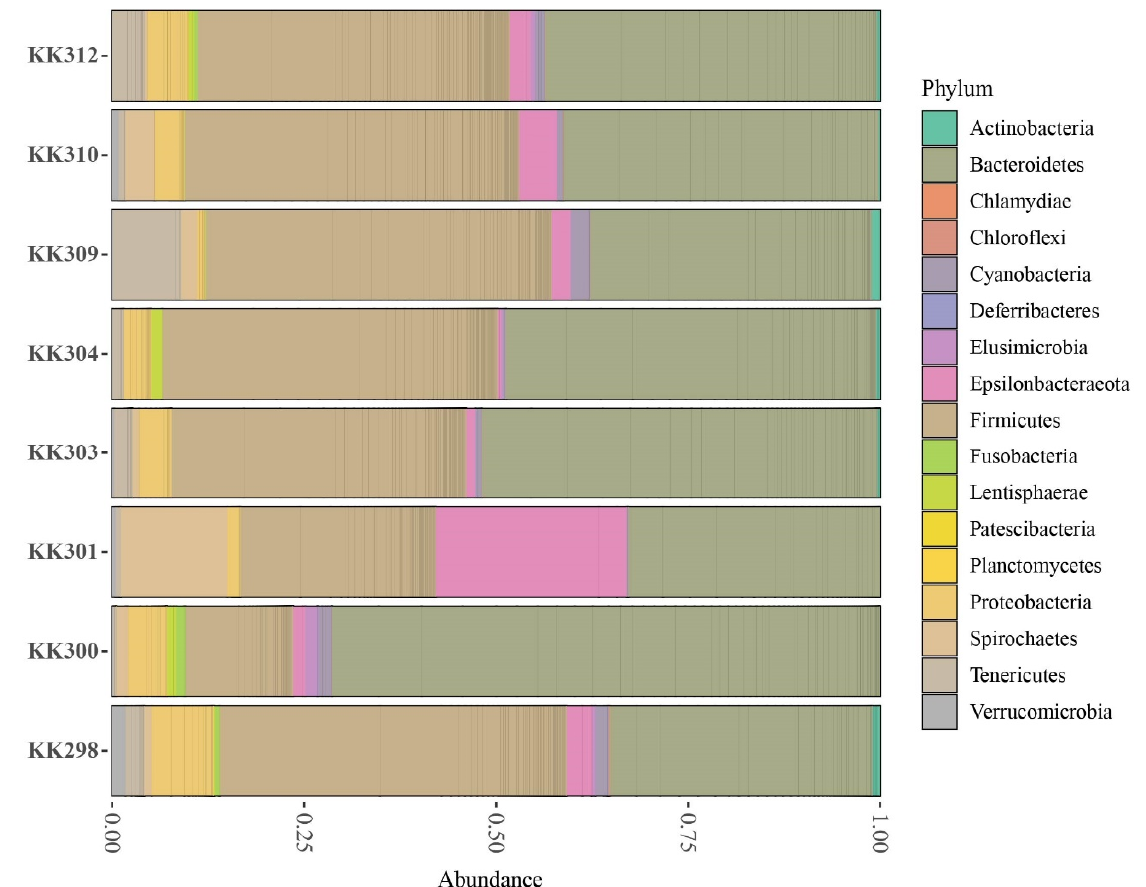
Figure 8. Faecal-microbiota diversity in eight samples from Grossa Island at the phylum level.